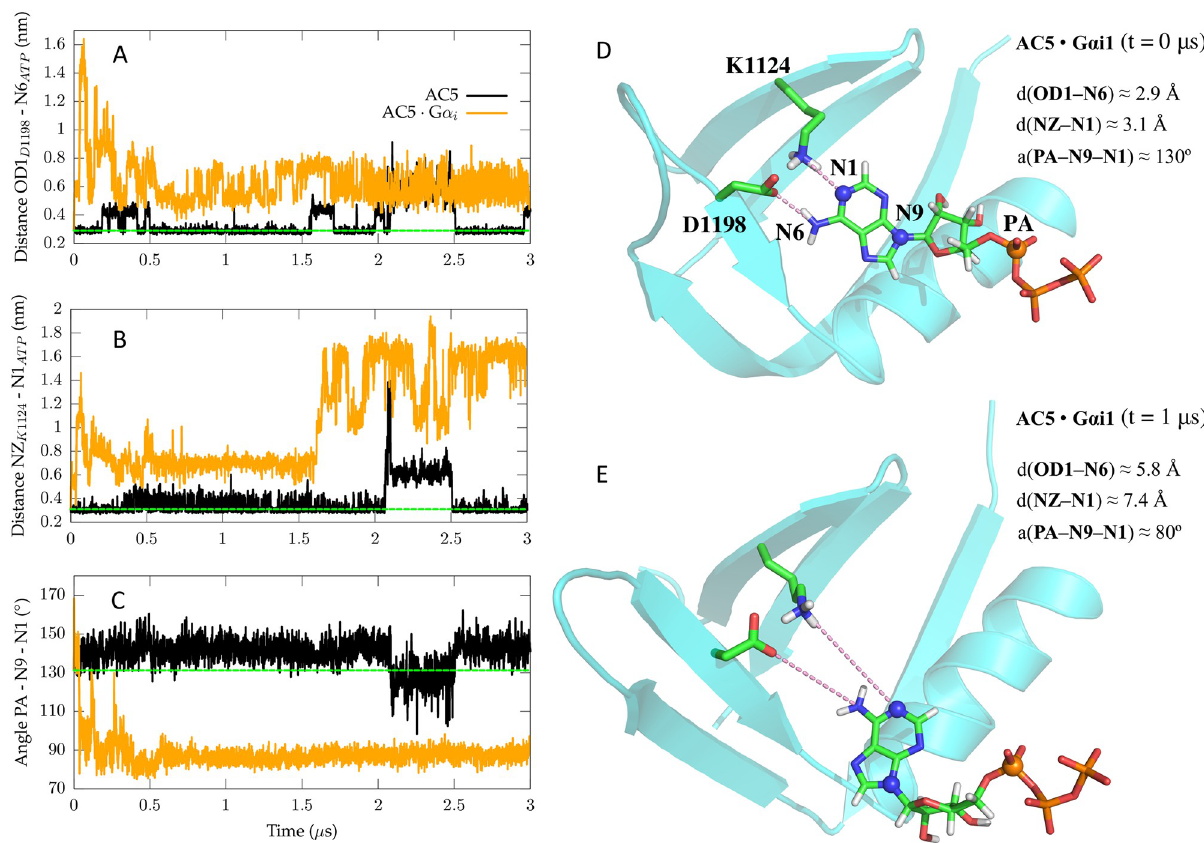
Fig 6. ATP’s adenine orientation in the active site of AC5:G α and G α -free AC5. Distances between the adenine moiety of ATP and D1198 (A), i 1 D1198(OD1)-ATP(N6), as well as K1124 (B), K1124(NZ)-ATP(N1) are shown. The position of these residues with respect to ATP is depicted in images (D) and (E). The dashed green line indicates the value for each initial distance in the AC5:G α and G α -free AC5 systems. (C) is a representation of an i 1 angle between ATP’s P α and two nitrogens in the adenine group, ATP(PA-N9-N1), which are highlighted in image (D). The dashed green line indicates the value of the initial angle in the AC5:G α i 1 and G α -free AC5 systems. (D) and (E) show the interactions between ATP and two residues, K1124 and D1198, at the beginning and at the end of the simulation of the AC5:G α system. ATP, K1124 and D1198 are represented in licorice (carbon in green, i 1 oxygen in red, nitrogen in blue, phosphor in orange and hydrogen in white) and the C2 domain is highlighted in cyan in cartoon representation. Distances between ATP and the two residues are shown in dashed pink lines with the corresponding values in Å ngstrom displayed in the right corner. The atoms used in the calculation of the angle plotted in (C) are depicted via blue and orange spheres, which are labeled in image (D).